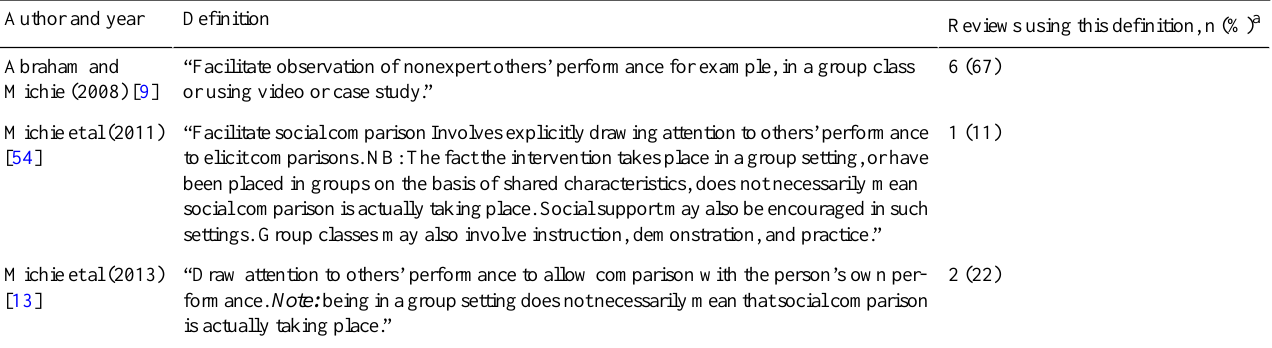
Table 4. Definitions of social comparison used in existing reviews of physical activity